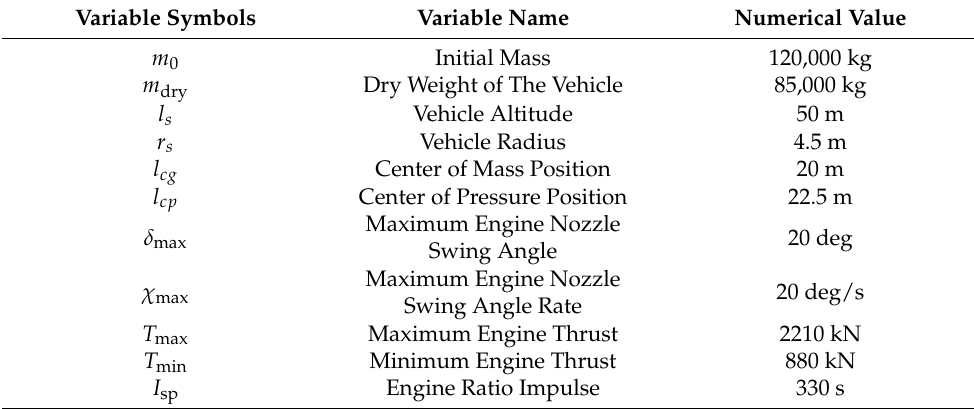
Table 1. SLV model